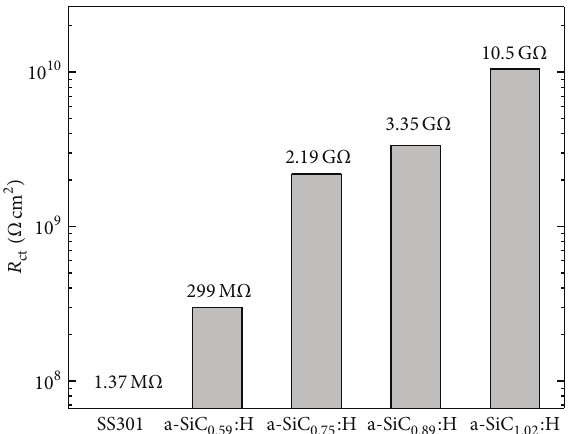
Figure 8: Resistance to charge transfer of the bare SS301 substrate and the a-SiC